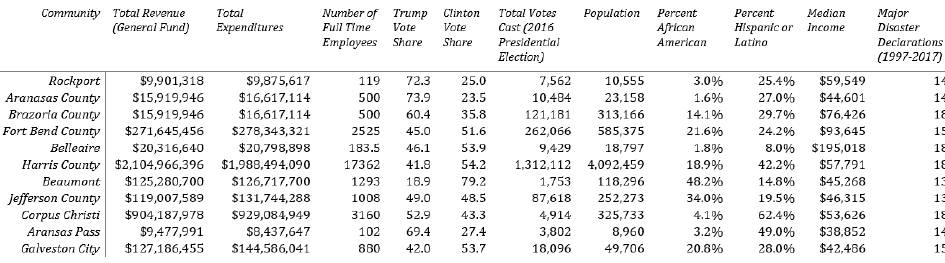
Source: Compiled by